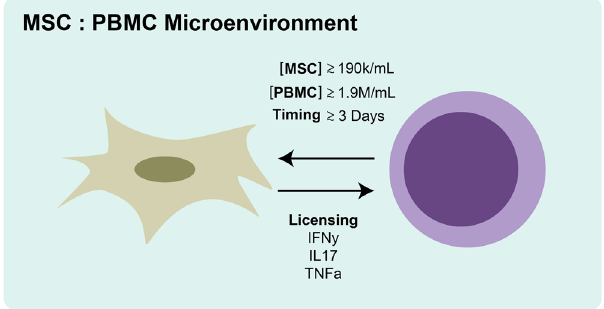
Figure 6. System specifications of MSC:PBMC microenvironment for an effective immunomodulatory outcome. We find that minimum MSC and PBMC are required for therapeutic function due to